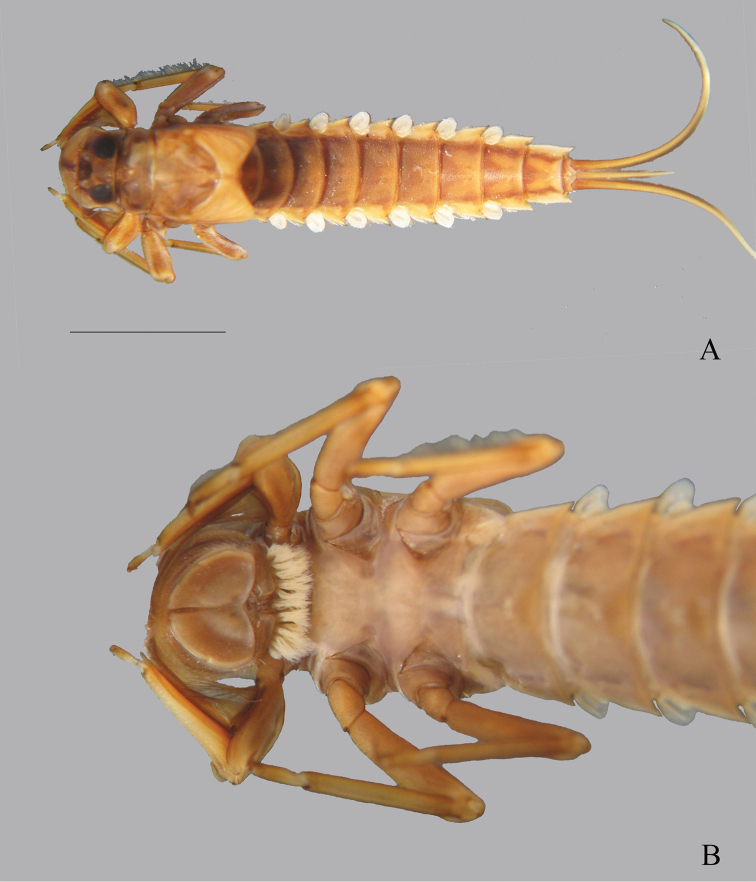
Oligoneuriopsis
elisabethaeA whole nymph (immature), dorsal view B dorsal view of head. Scale bar: 5 mm (A).